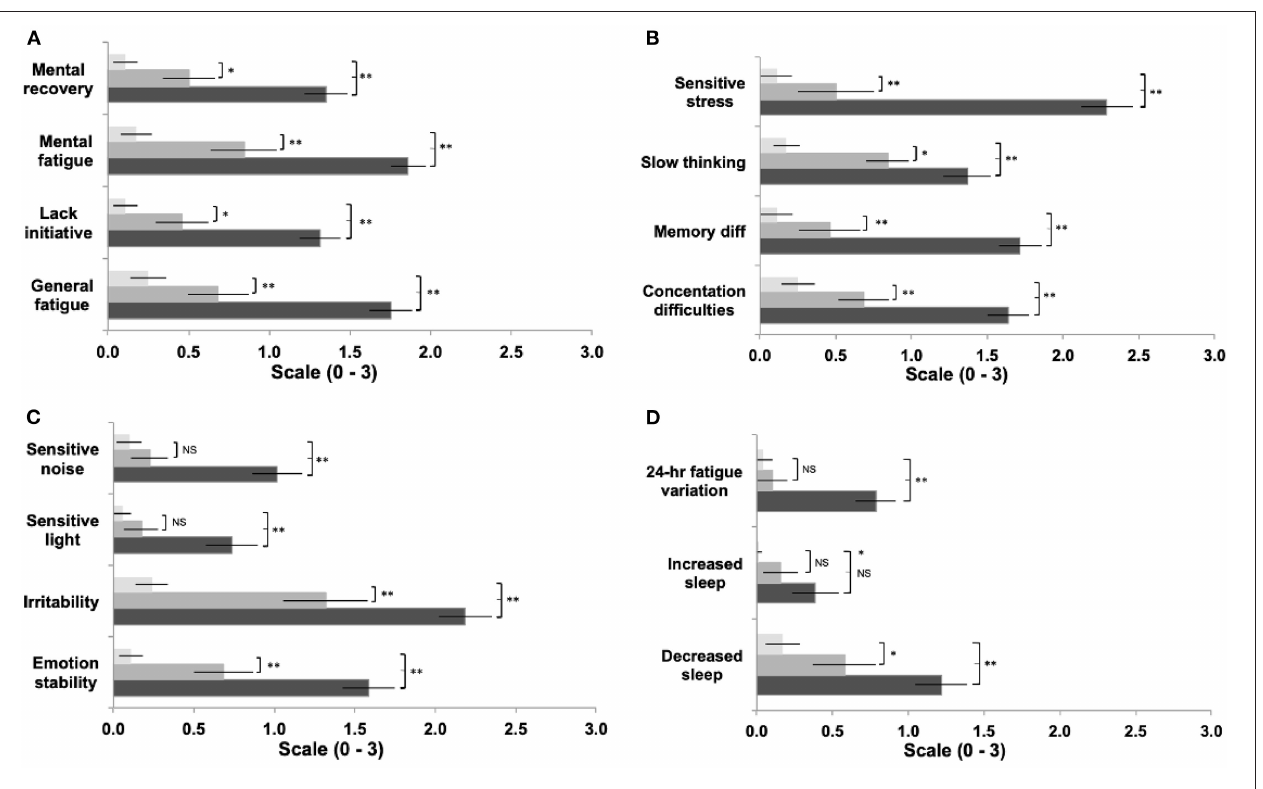
FIGURE 1 | Comparison between groups of symptom items reported in the Fatigue and Related Symptom Survey (a-d) . Light bars represent controls, grey bars represent ’asymptomatic’ group, black bars represent the ’symptomatic’ group. (Data expressed and mean ± 95%CI; * p < 0.05; ** p < 0.01). presented in Table 3 and TMS and somatosensory variables are presented in Table 4